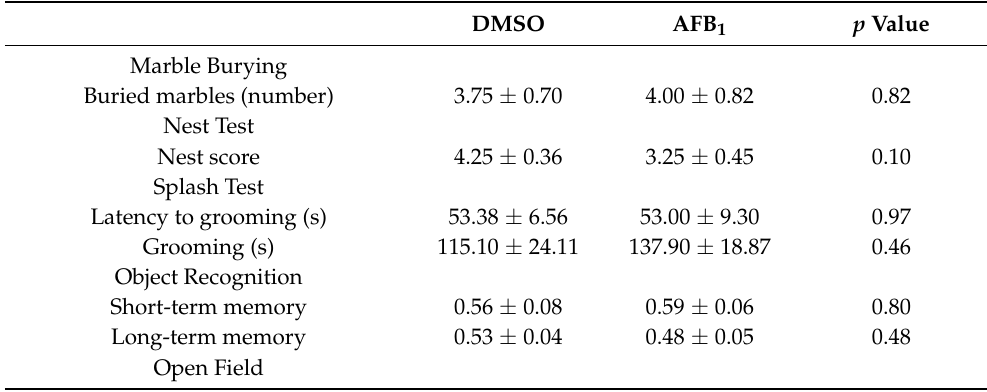
Table 3. Effect of intermittent administration of AFB 1 (250 µ g/kg b.w., i.g.) or 2% DMSO (10 mL/kg b.w., i.g.) on the behavioral